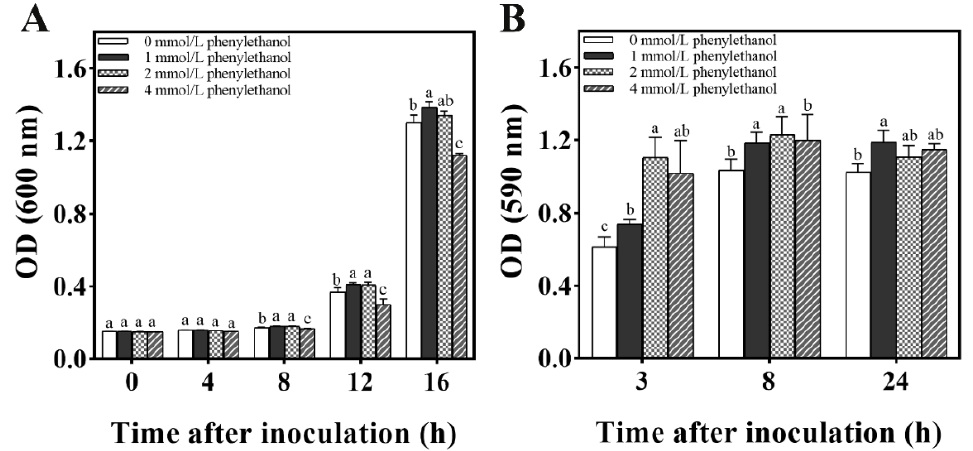
Figure 6. Effect of various concentrations of phenylethanol on ( A ) cell growth and ( B ) biofilm formation. Error bars indicate the standard deviation, and different letters indicate significant differences ( p < 0.05).